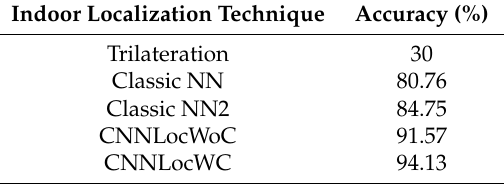
Table 9. Comparison of the accuracy associated with different algorithms using a grid of size 2 m × 2 m and 10